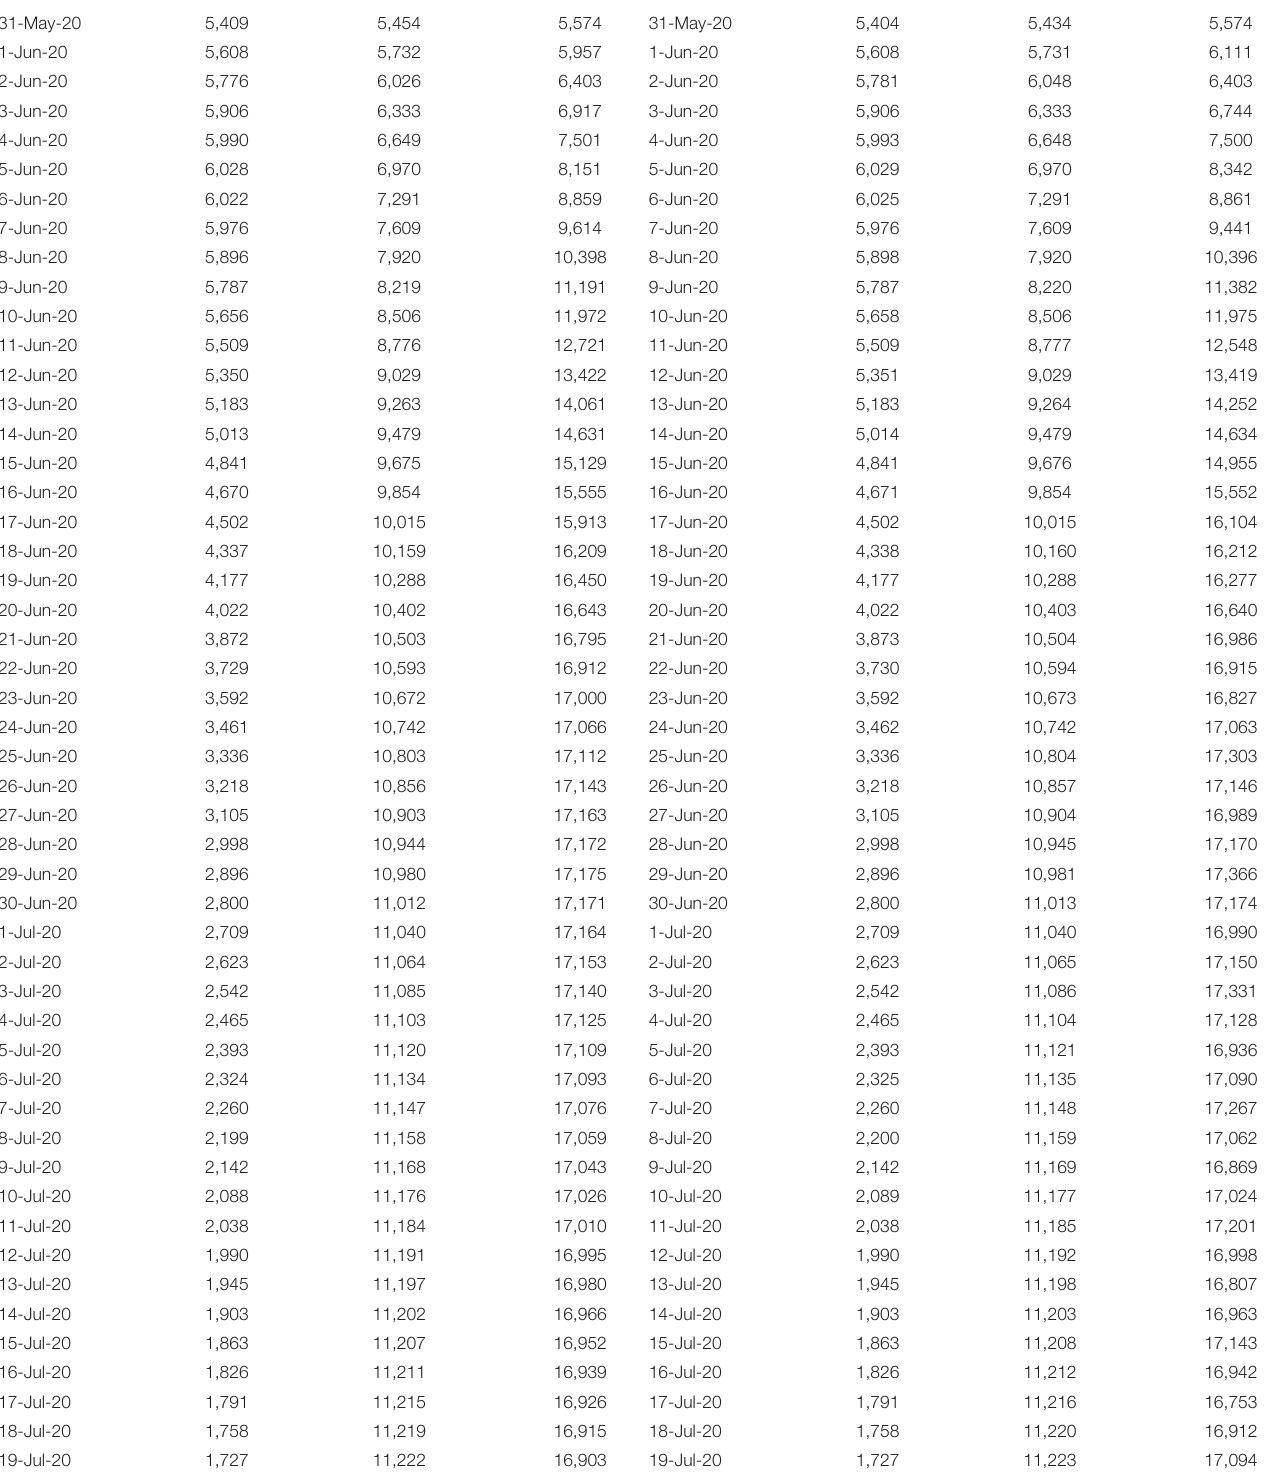
TABLE 4 | Predicted value Ypred for D1 using standard models. TABLE 5 | Predicted value Ypred for D1 using hybrid